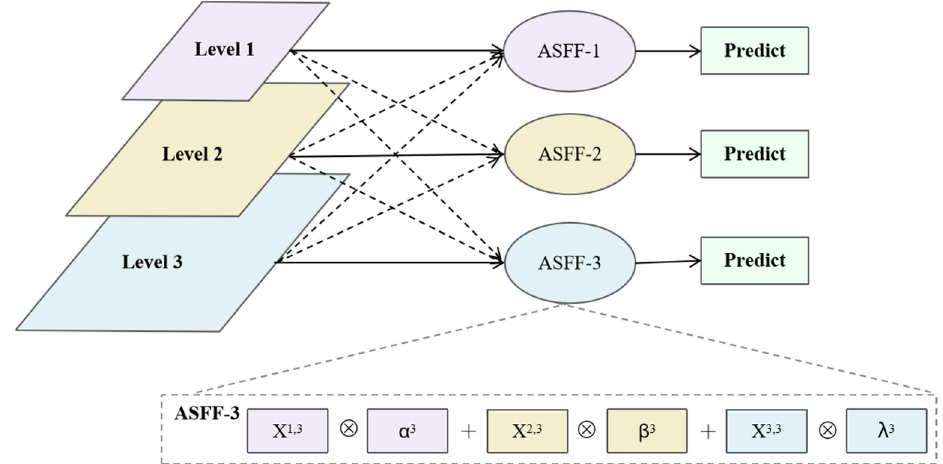
Figure 5. Adaptively spatial feature fusion.